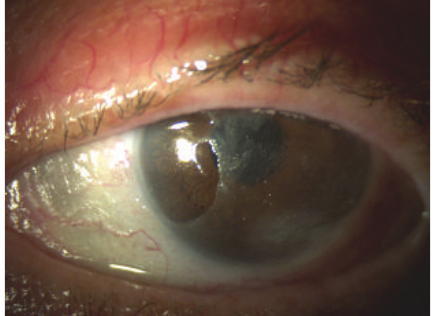
Figure 10: Left eye after 3 weeks of therapy.